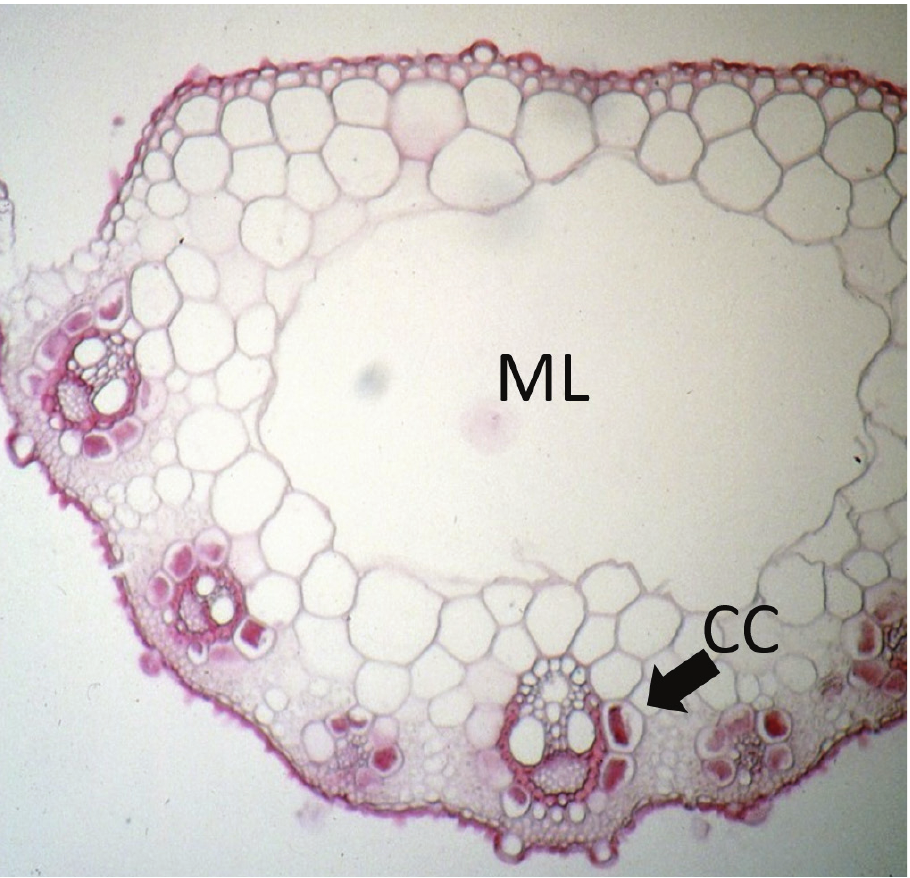
Figure 4. Cross section of leaf of D. fusca subsp. muelleri (Badman 675) showing midrib (central area), midrib lacuna (ML) and vascular bundle with centripetal chloroplasts (CC) of the mestome